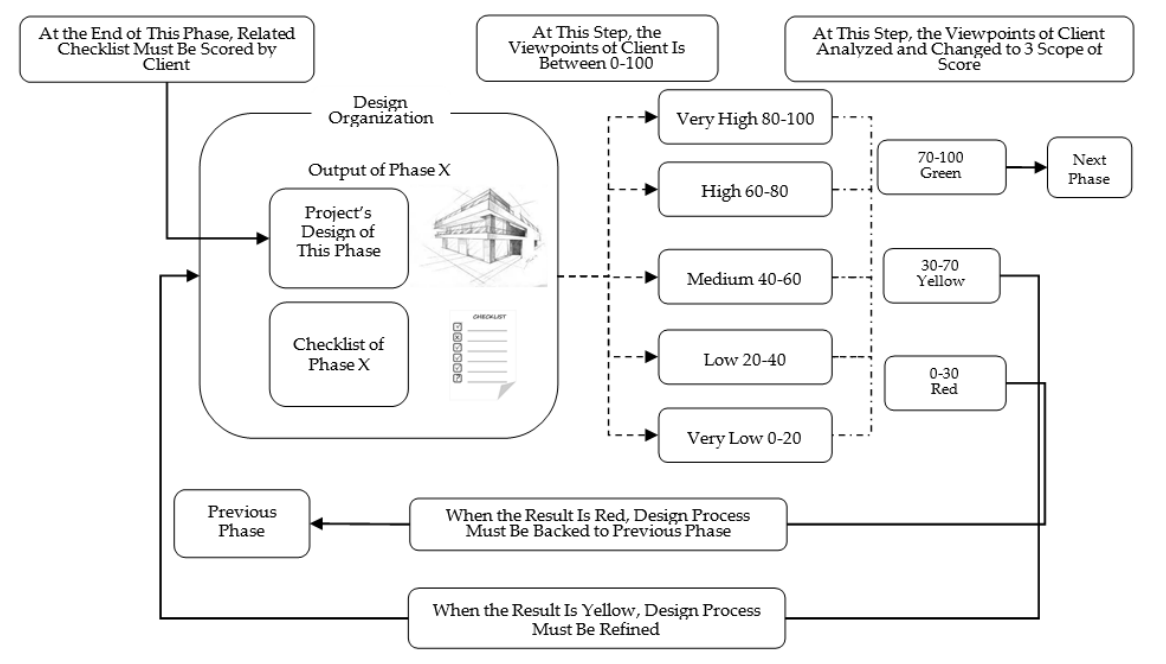
Figure 5. Flow diagram of the proposed model for the design phase of a construction project.